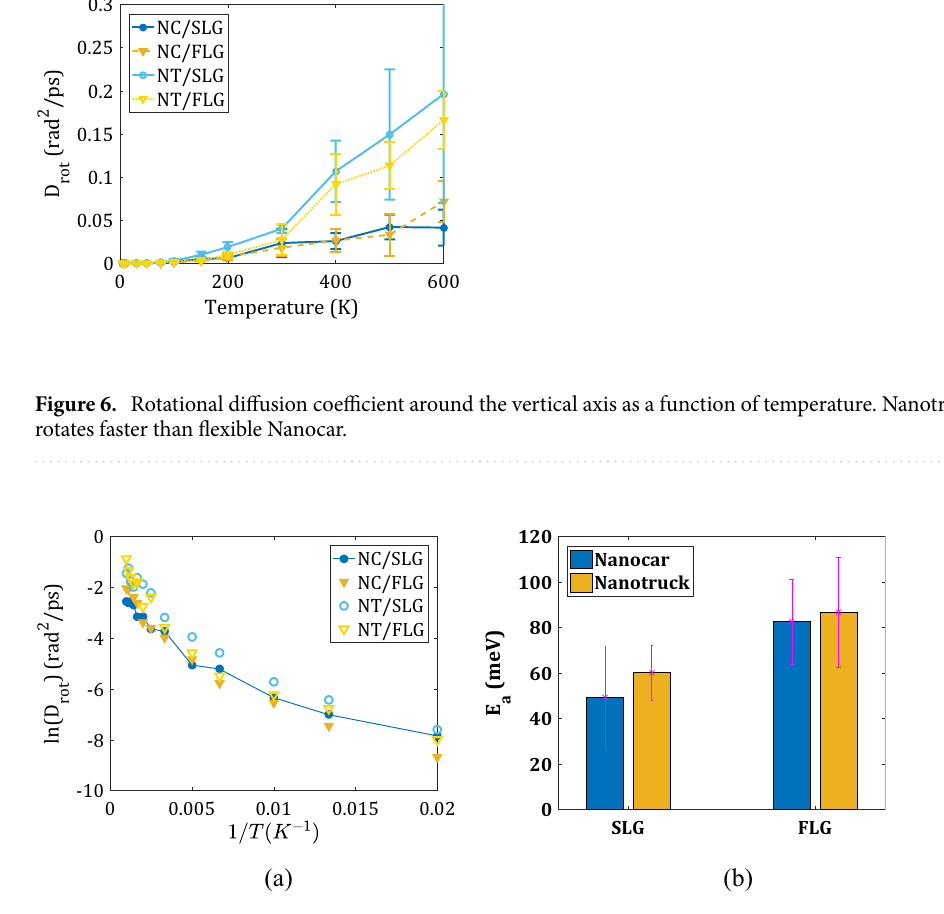
Figure 7. Quantification of rotation about normal z-axis: ( a ) Arrhenius plot for Nanocar and Nanotruck diffusion coefficients on two substrate types (SLG—blue, FLG—yellow); ( b ) activation energies computed for all systems.